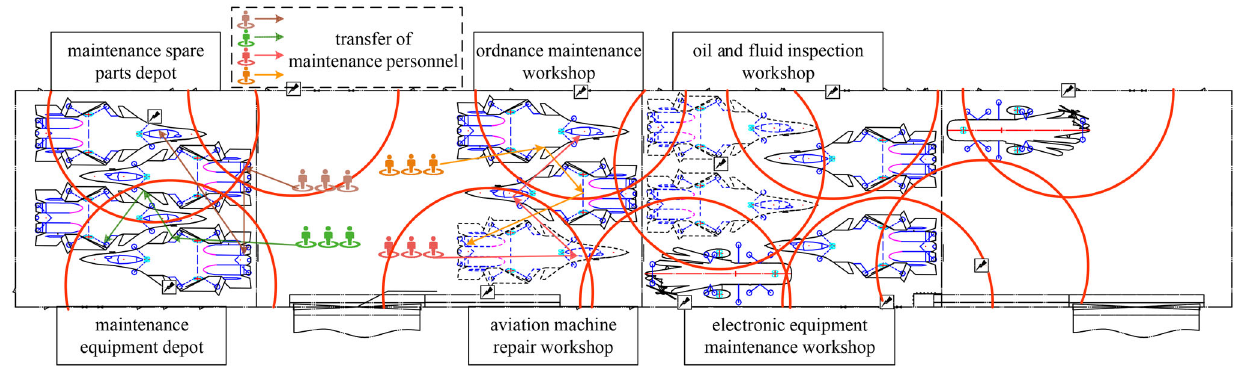
Fig. 1 Maintenance resources and environment of Kuznetsov aircraft carrier hangar